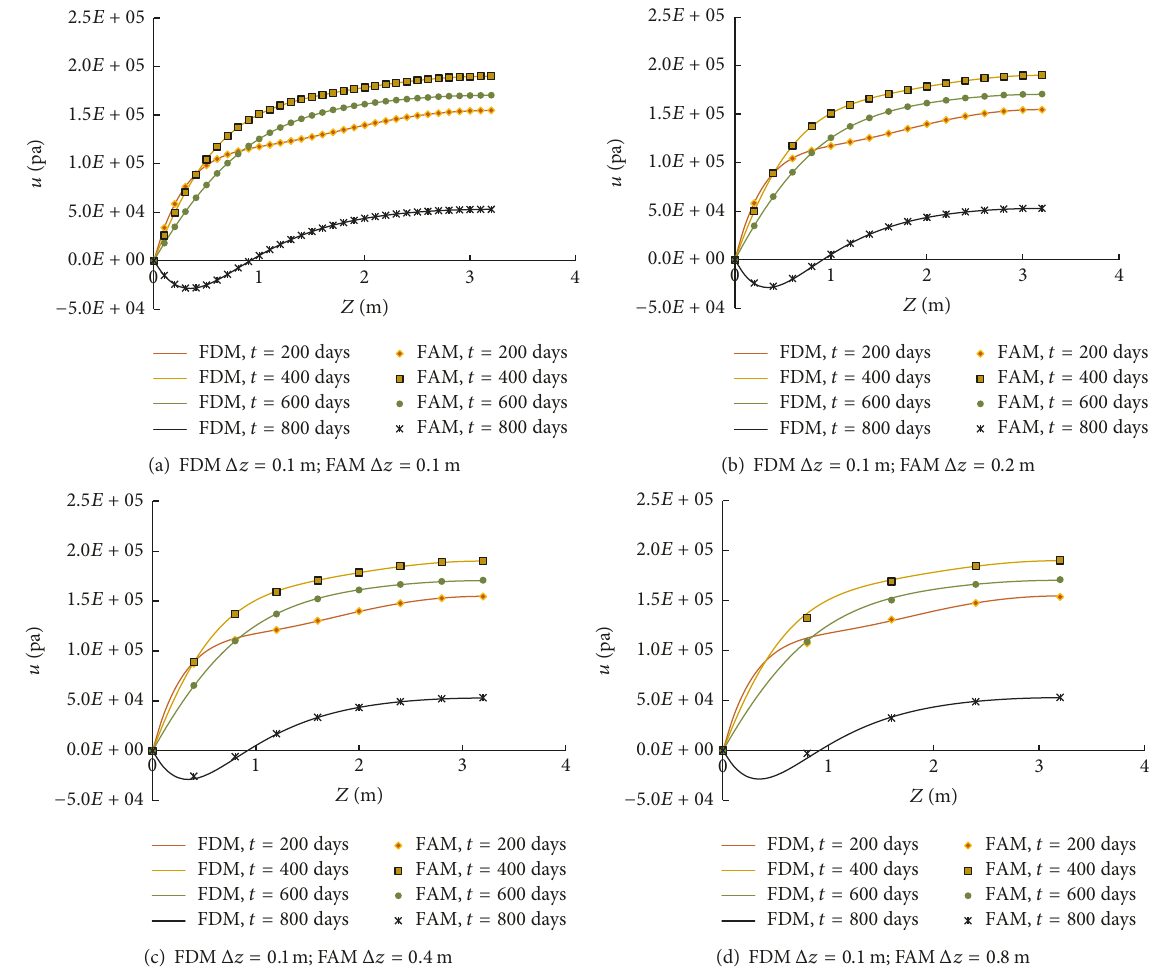
Figure 10: Comparison between the results of FAM and the results of